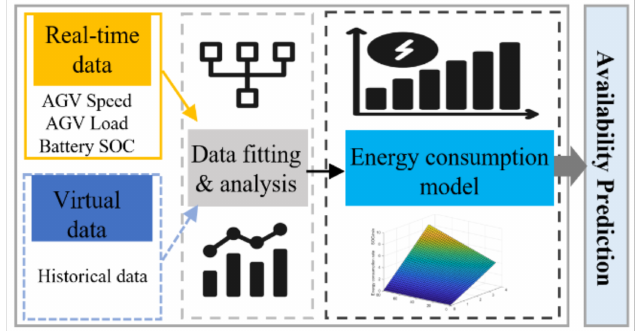
Figure 4. Real-time data based AGV energy consumption